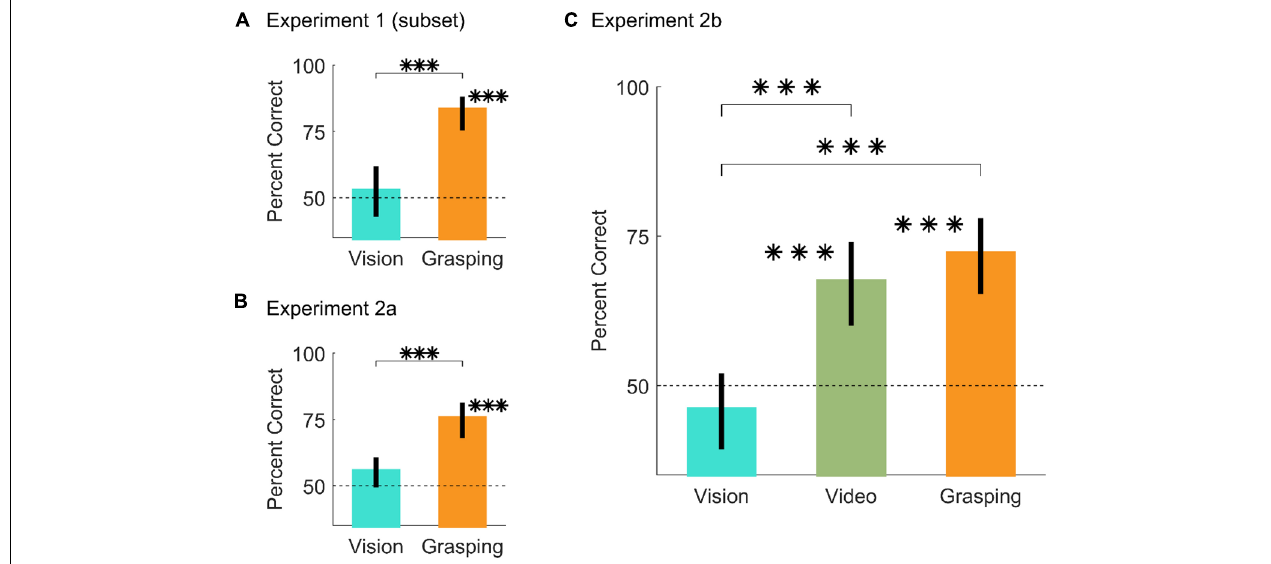
FIGURE 4 | Results from Experiment 2. (A,B) Percent correct grasp optimality judgments for vision and grasping sessions, averaged across objects, and participants, for (A) the subset of conditions from Experiment 1 that drives the difference between vision and grasping, and (B) the same subset of conditions replicated in Experiment 2a. (C) Percent correct grasp optimality judgments for vision, video, and grasping sessions, averaged across objects and participants, for Experiment 2b. In all panels, error bars are 95% bootstrapped confidence intervals of the mean and chance performance is 50% correct (graydotted line). ∗∗∗ p <